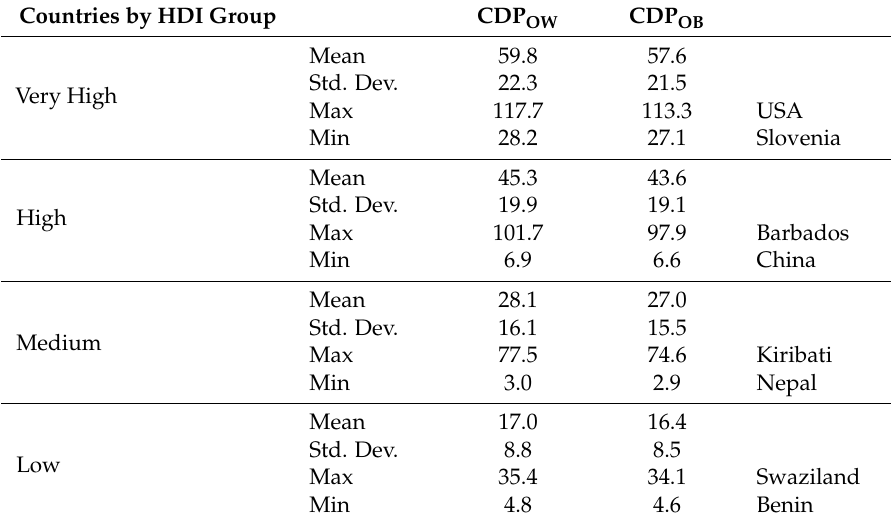
Table 3. Carbohydrate dietary pattern (CDP) index.